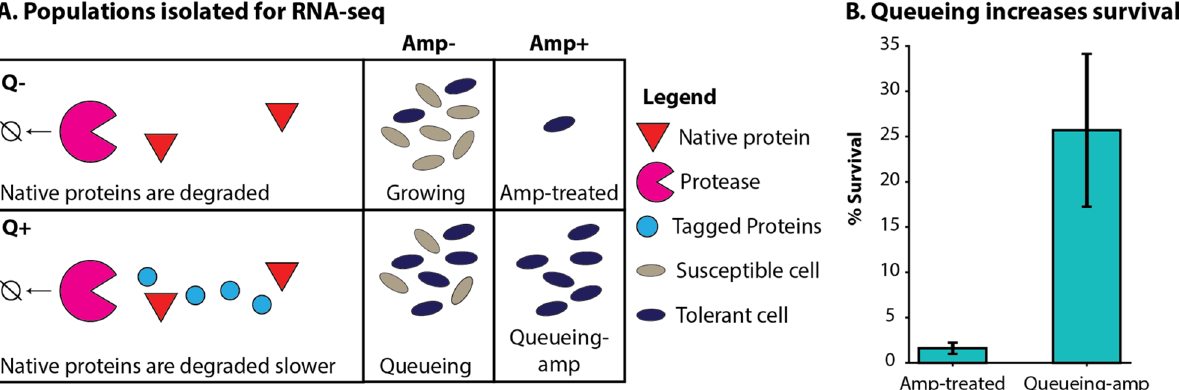
Figure 4. Proteolytic queueing increases survival of ampicillin. ( A ) We obtained RNA-sequencing (RNA-seq) data on populations with (Q+) or without (Q-) induction of a queue at the protease ClpXP via overexpression of CFP-LAA, and populations with (Amp+) or without (Amp-) ampicillin treatment (100 μg/ml). ( B) Percent survival of cells after ampicillin treatment for three hours without a queue (Amp-treated) or with a queue